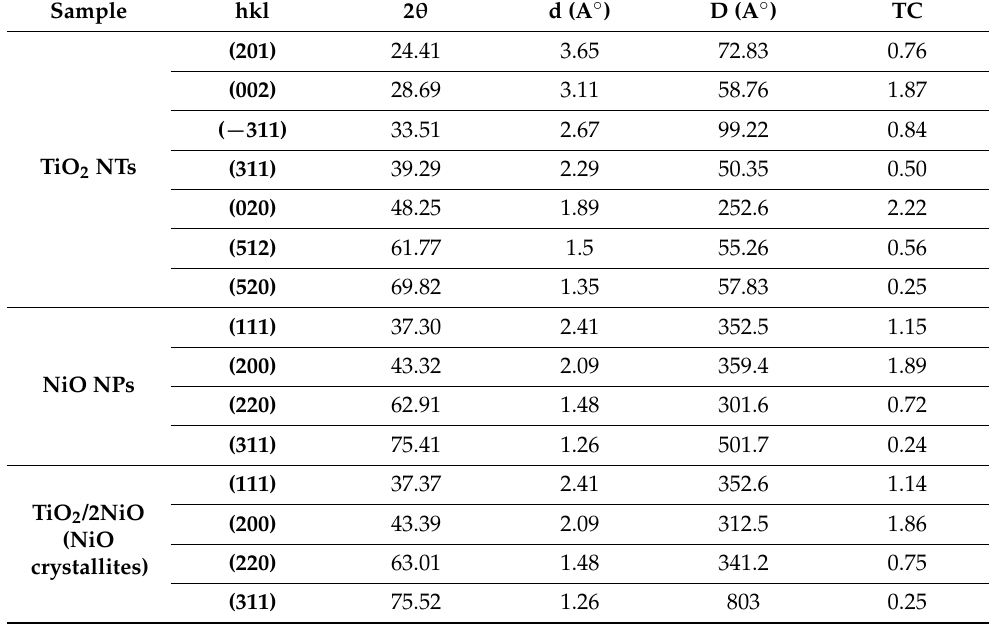
Table 1. The structural parameters of the photocatalysts from XRD data; crystallites sizes (D), interplanar distances (d), and texture coefficients